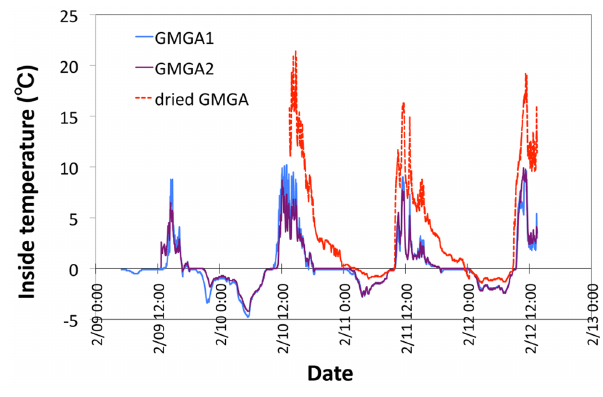
Figure 5. Internal changes in temperature of 2 GMGA and 1 dried GMGA left on a rock during the 2013 research period (February 9–12, 2013).